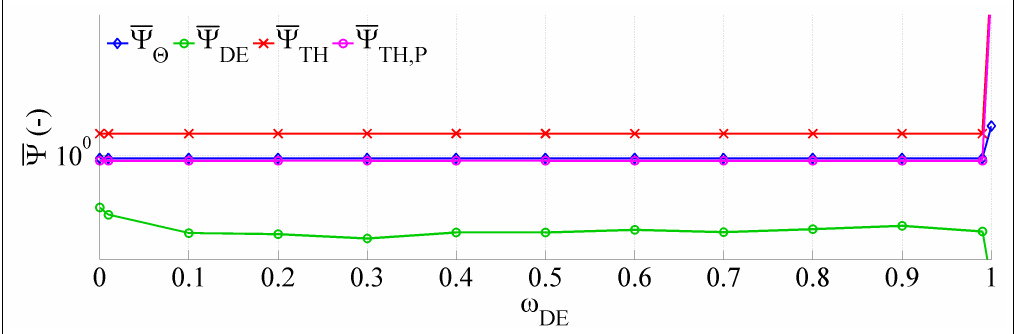
Figure 13. The criteria function member values as the function of ω DE .